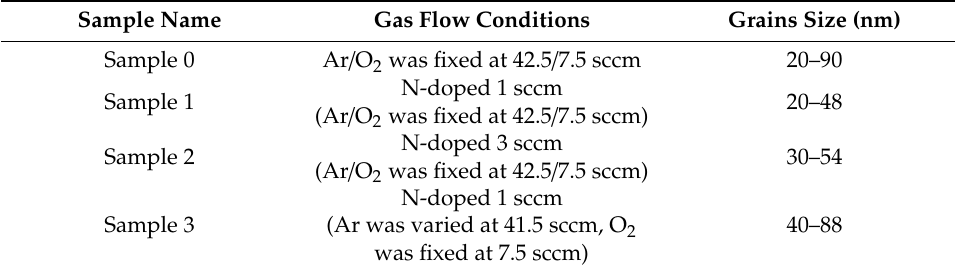
Table 2. Process characteristics and layer structure of Cu 2 O:N thin films.